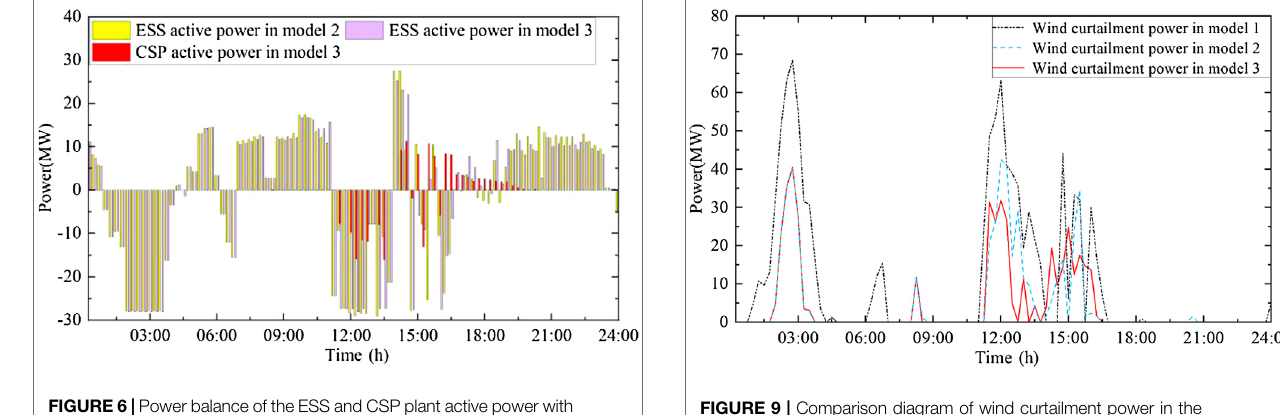
FIGURE 9 | Comparison diagram of wind curtailment power in the scheduling model.